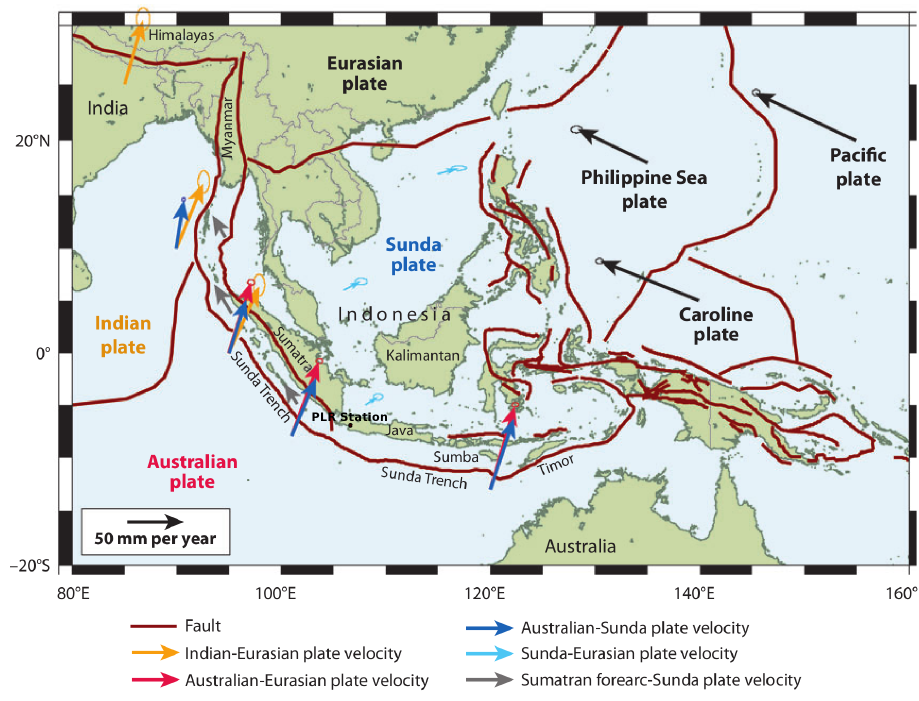
Fig. 1. The tectonic settings of Indonesia and Pelabuhan Ratu station (after McCaffrey,